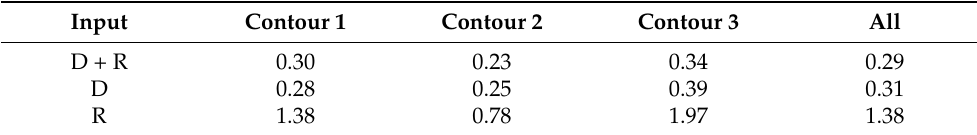
Table 4. Comparison between models with different features in the MLE(m) metric. Here, D denotes ToF distance and R denotes the RSS.